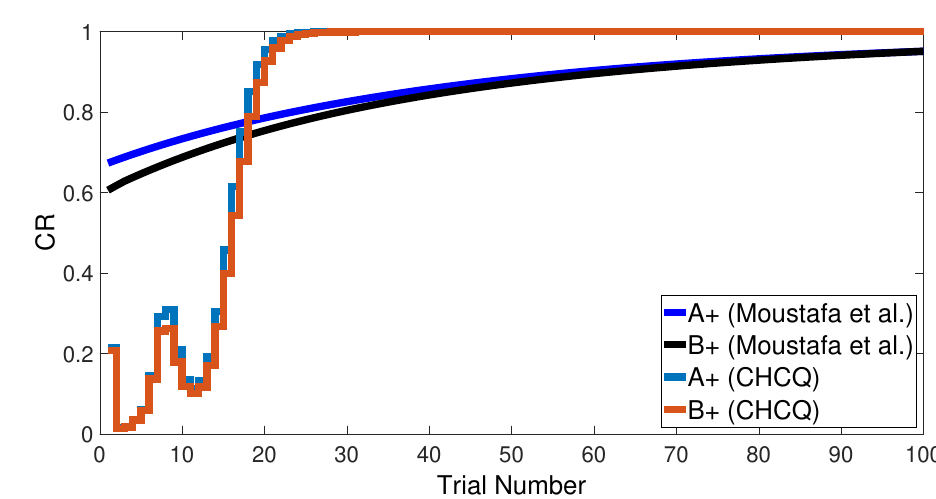
Figure 16. Extended overshadowing task for the intact